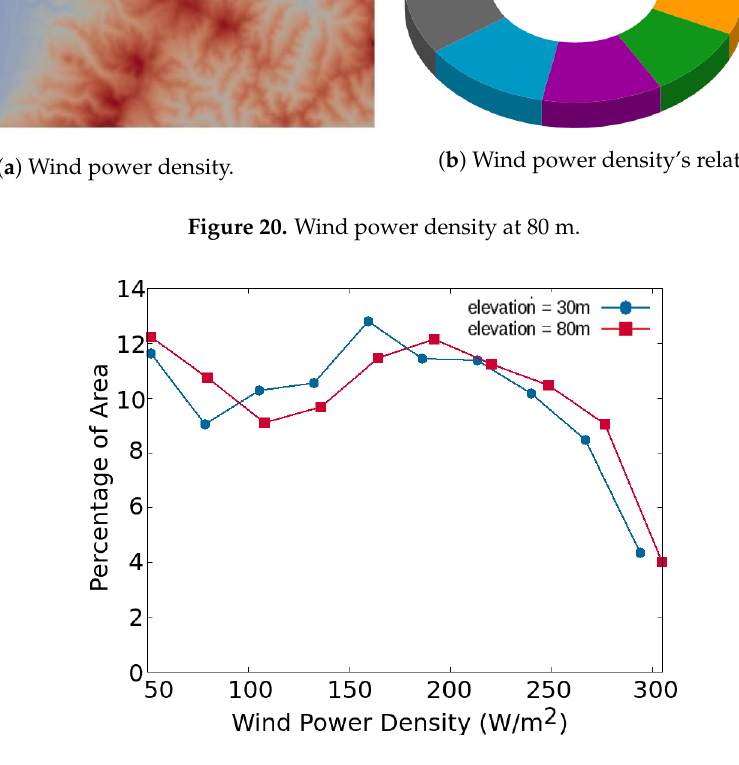
Figure 21. Wind power density’s relative distribution by areas at two